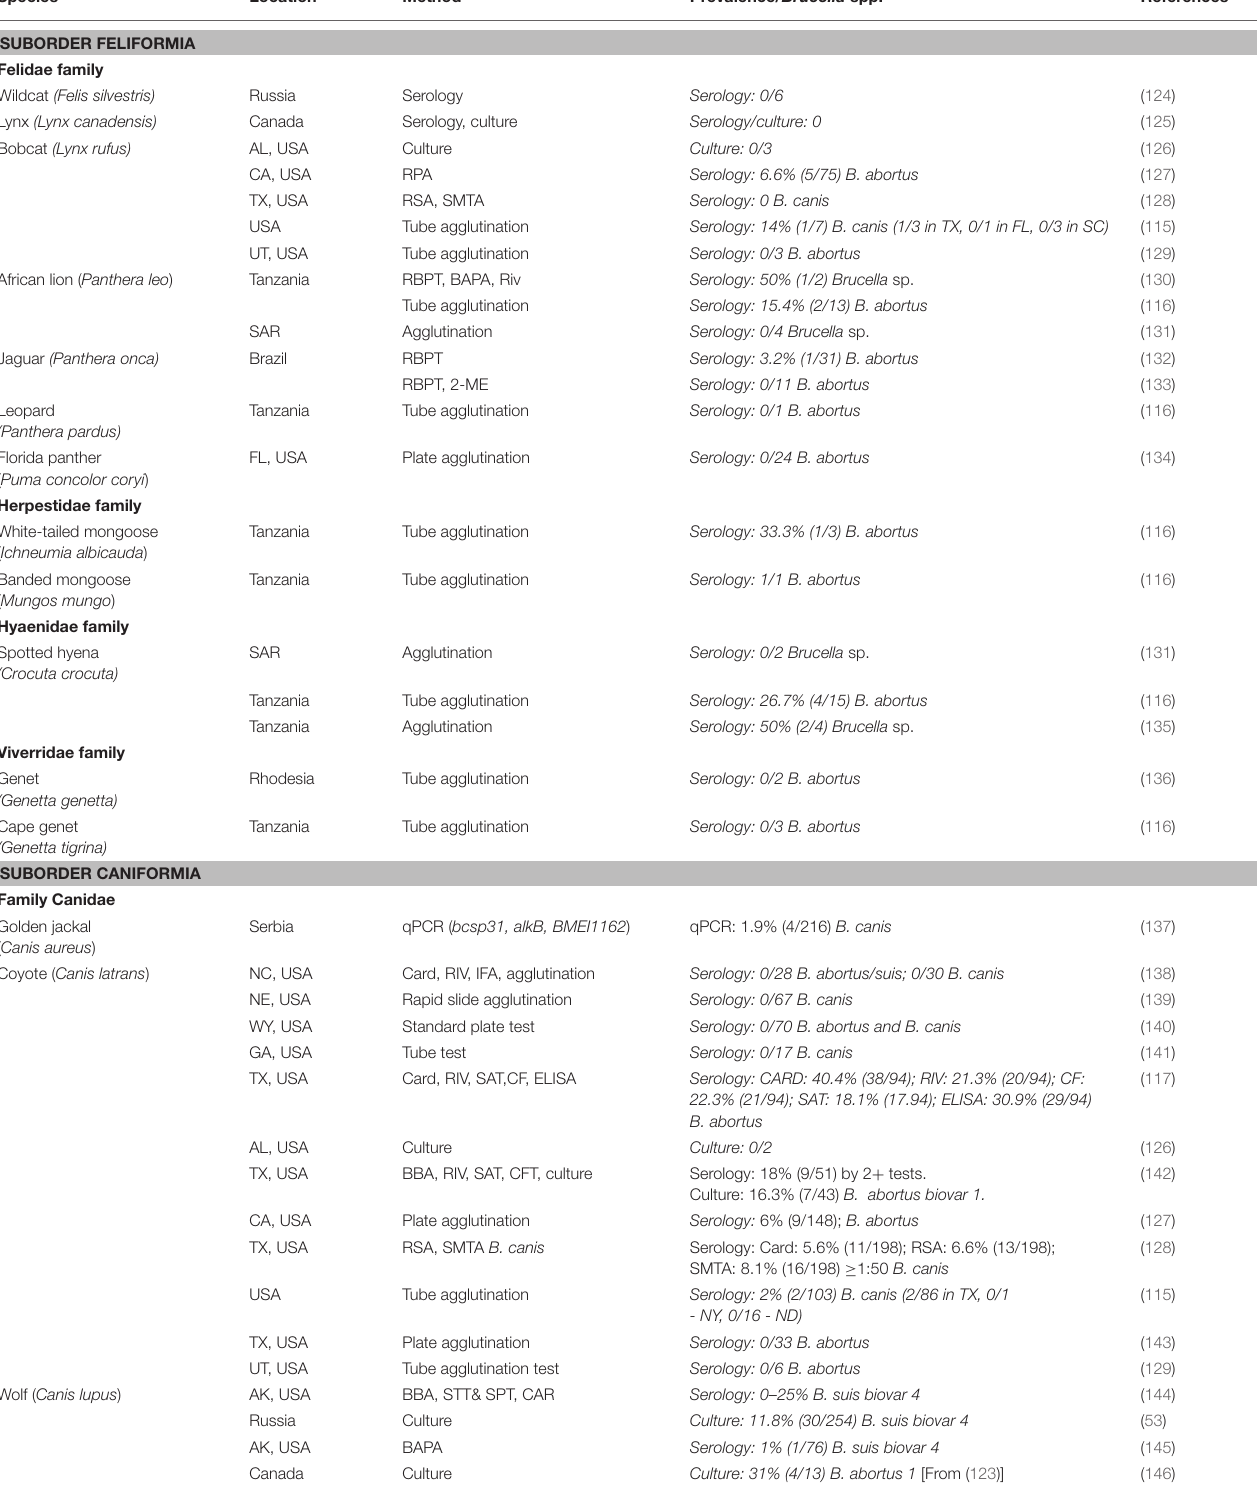
TABLE 2 | Brucella studies in wild Carnivores by species.